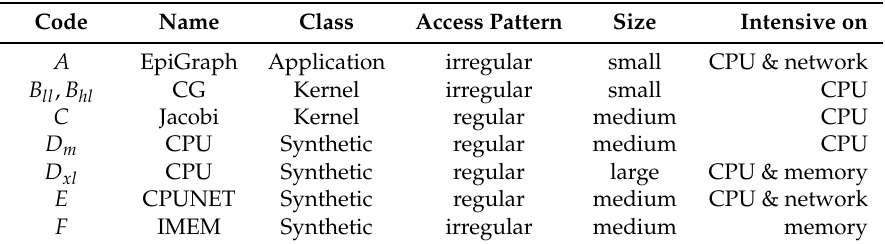
Table 1. Use cases considered in the